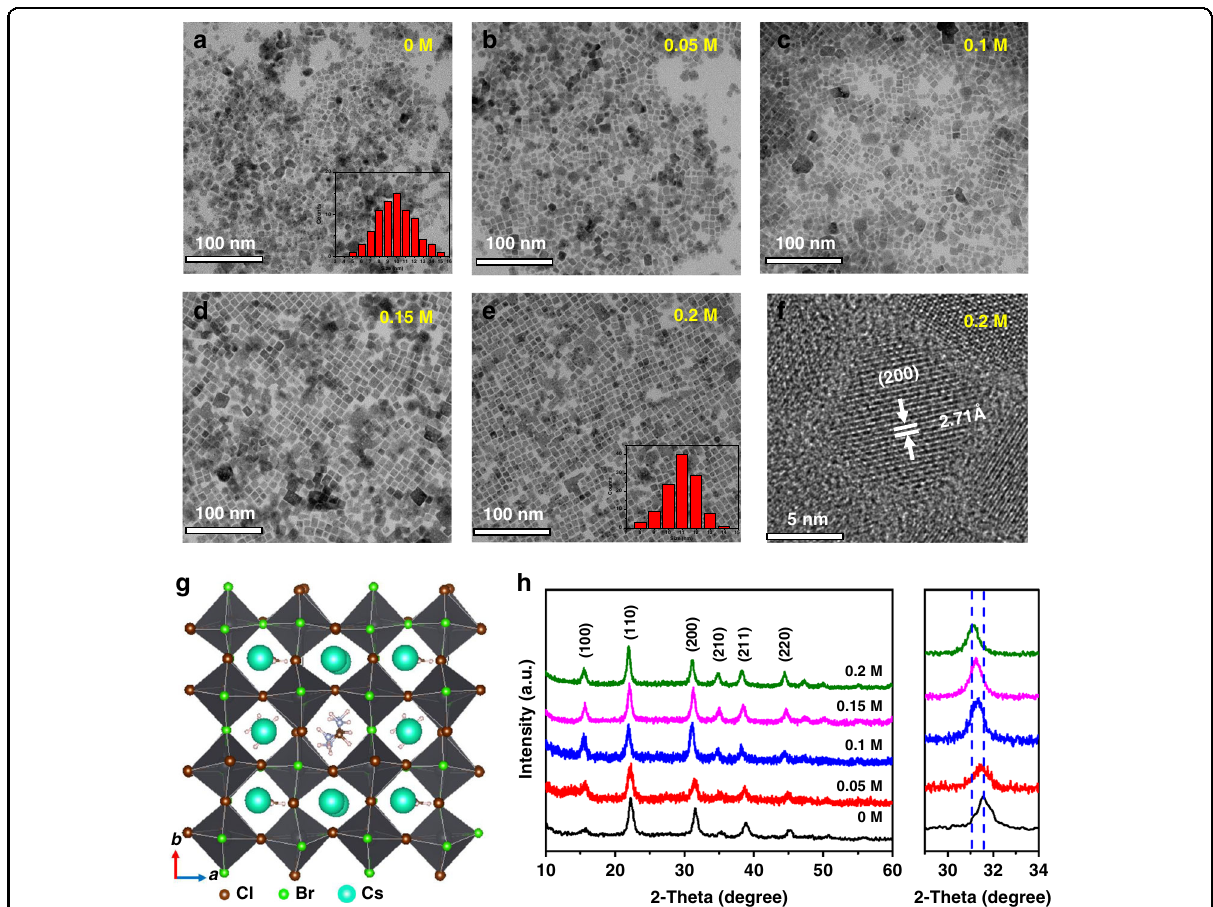
Fig. 1 The structure and morphology of undoped and FA-doped CsPb(Cl 0.5 Br 0.5 ) 3 QDs. TEM images of a undoped QDs, b 0.05 M FA cations adding, c 0.1 M FA cations adding, d 0.15 M FA cations adding, and e 0.2 M FA cations adding. f high-resolution TEM images of 0.2 M FA cations adding. g the crystal structure graph. h XRD patterns of undoped and FA cation doped CsPb(Cl 0.5 Br 0.5 ) 3 QDs. The inserts of ( a ) and ( e ) are grain size statistical